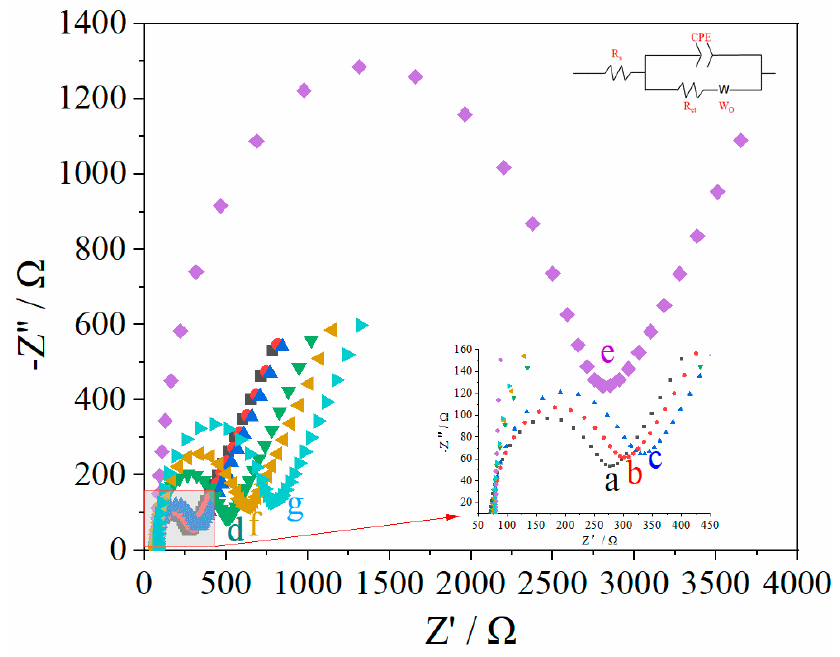
Figure 2. The EIS responses of MIPs/dsDNA sensor under different conditions in 0.005 mol/L of K 4 [Fe(CN) 6 ]/K 3 [Fe(CN) 6 ] (contain 0.1 mol/L KCl) solution over the frequency range from 0.1 Hz to 100 kHz, with an alternating voltage of 5 mV (a: bare Au electrode, b: ssDNA, c: dsDNA, d: dsD- NA-L-Pen, e: electropolymerization, f: elution, g: rebound).